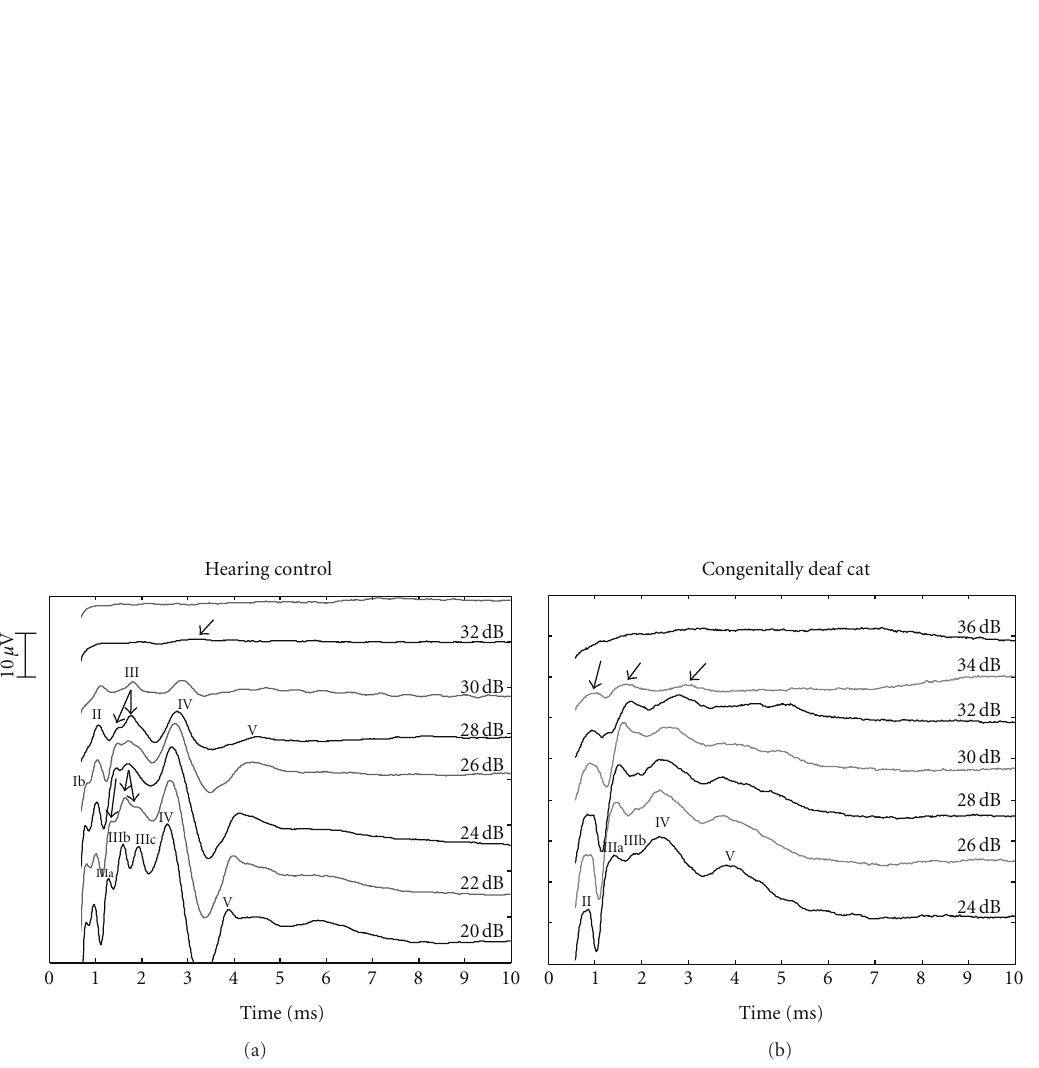
Figure 1: Examples of E-ABRs recorded from an adult hearing control (a) and an adult CDC (b). Arrows point to E-ABR components at threshold intensity. Current levels are given in dB attenuation (re 3mApp). In general, similar morphology was observed, with some less-well di ff erentiated waves in CDCs. Stimulus artifact (starting at 0ms) was